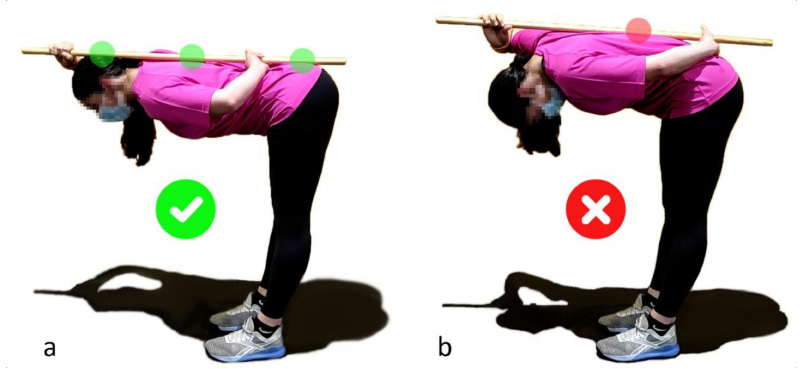
Figure 1. ( a ): Hip hinge with neutral spine; ( b ): Hip hinge without neutral spine.